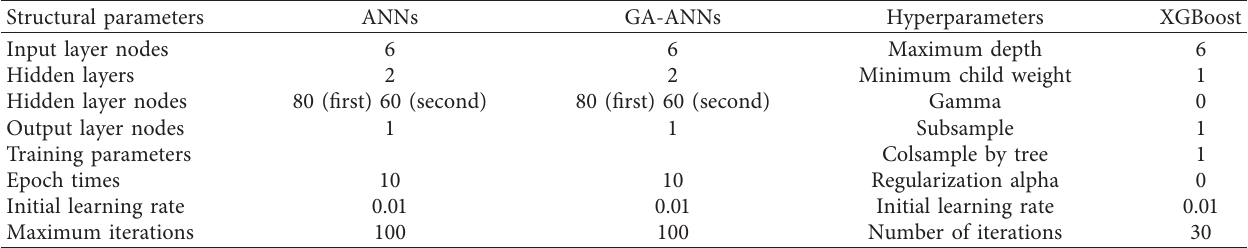
Table 5: Setting parameters of ANN, GA-ANN, and